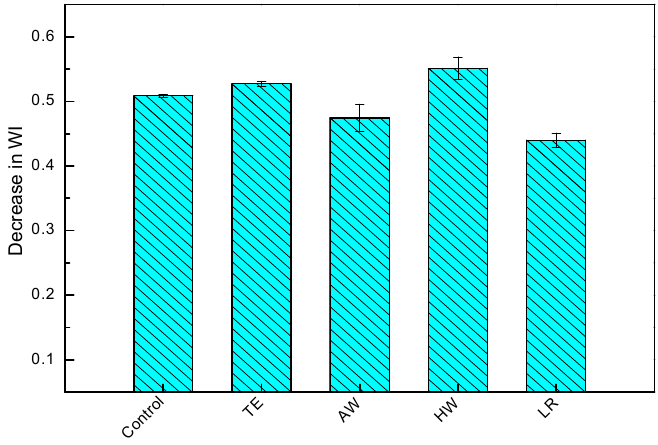
Figure 3. Decreased WI of the samples after weathering.